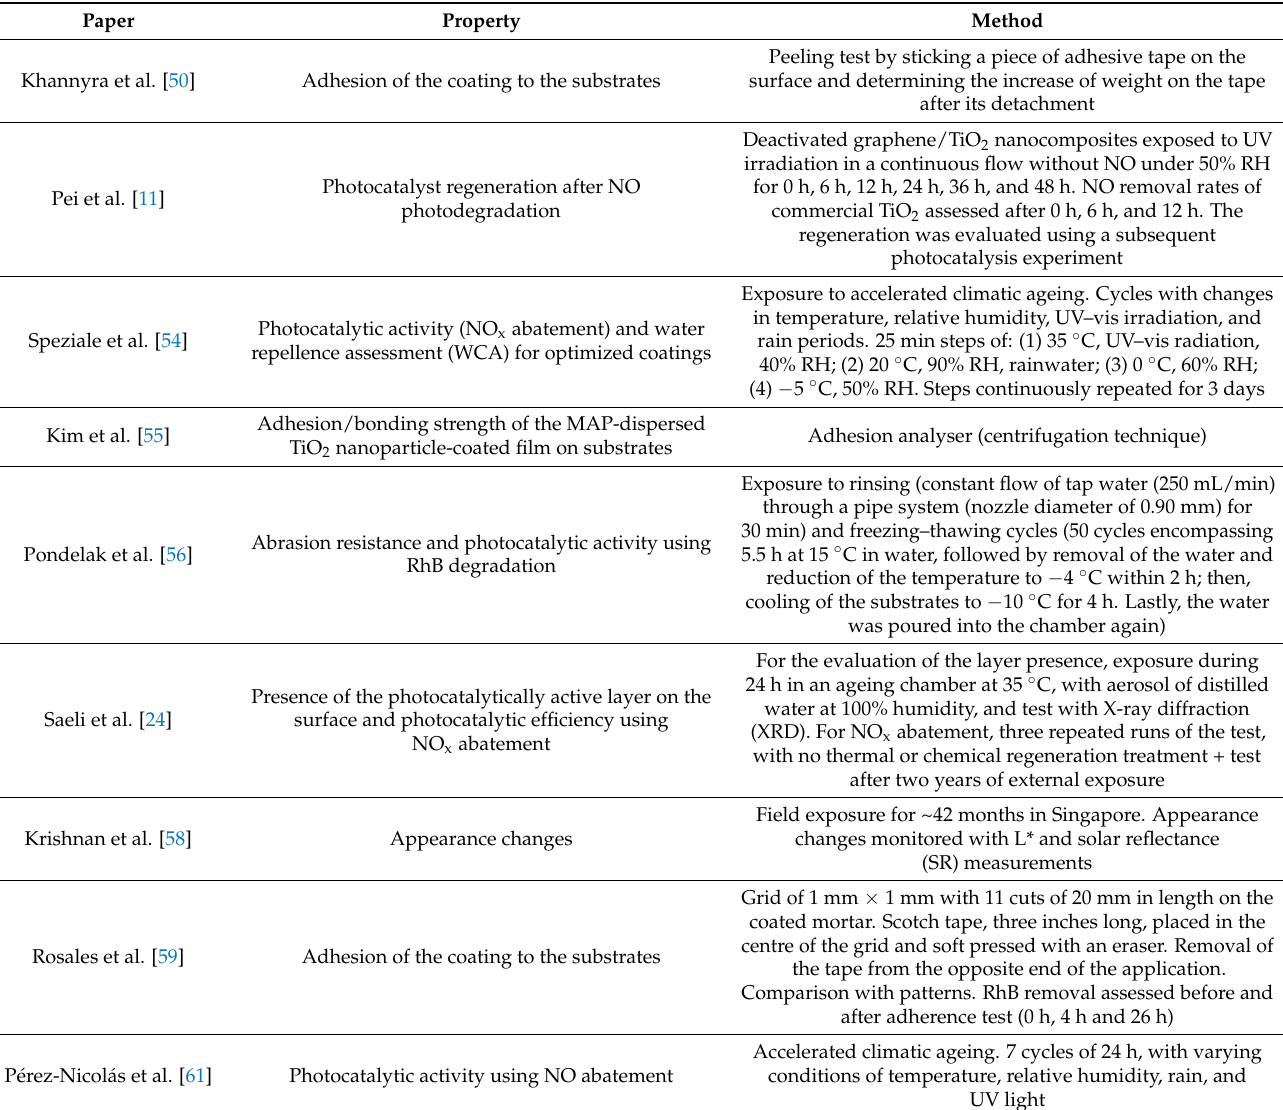
Table 7. Properties evaluated and method for ageing or assessing the results used by the papers to study durability-related issues for TiO 2 -based